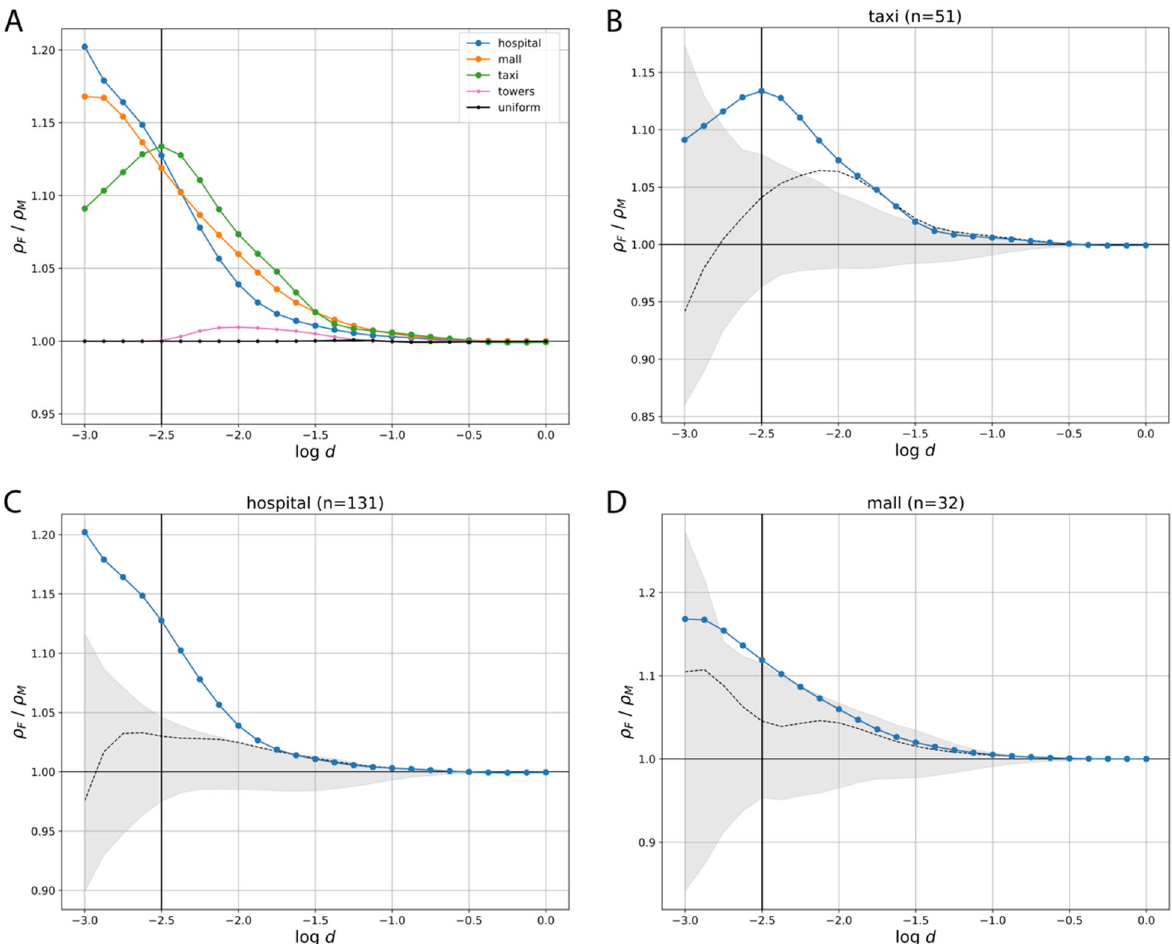
Fig. 4 Gender differences in visit patterns. Gender ratio ρ F / ρ M as a function of the bandwidth d (decimal logarithm of the value in decimal degrees), for a few selected POI types, including the "towers ’‘ and "uniform ” reference layers ( a ). The vertical line corresponds to a kernel bandwidth comparable to the spatial resolution afforded by the CDR data we use. The gender ratio ρ F / ρ M as a function of the bandwidth d is compared to two reference null models for “ taxi ” ( b ), “ hospital ” ( c ), and “ mall ” ( d ). The shaded area indicates, for each value of the bandwidth d , the 95% con fi dence interval of the values ρ computed on the realizations of the spatial sampling null model. The dashed line indicates the gender ratio computed on the spatially perturbed null